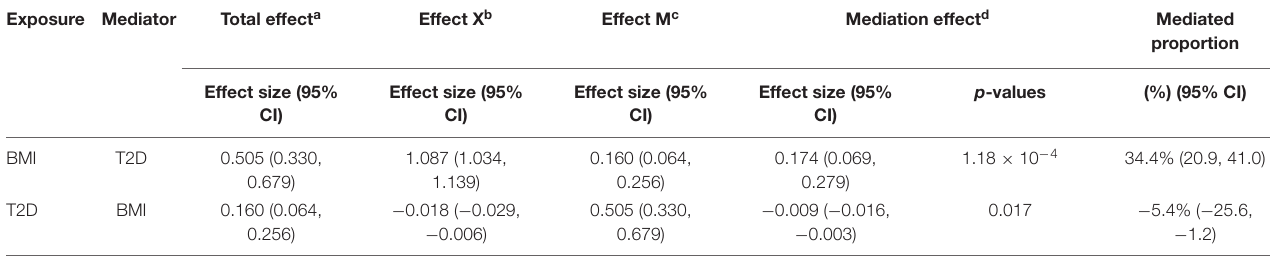
TABLE 1 | Mediation effect of body mass index on carpal tunnel syndrome via type 2 diabetes and type 2 diabetes on carpal tunnel syndrome via body mass index. Exposure Mediator